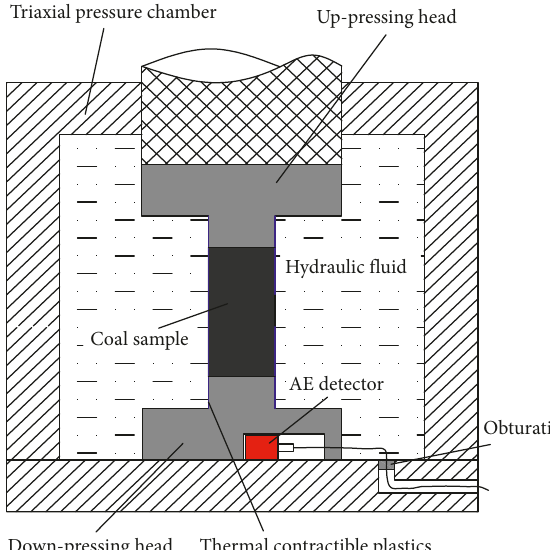
Figure 5: AE detector placed in a triaxial chamber head.